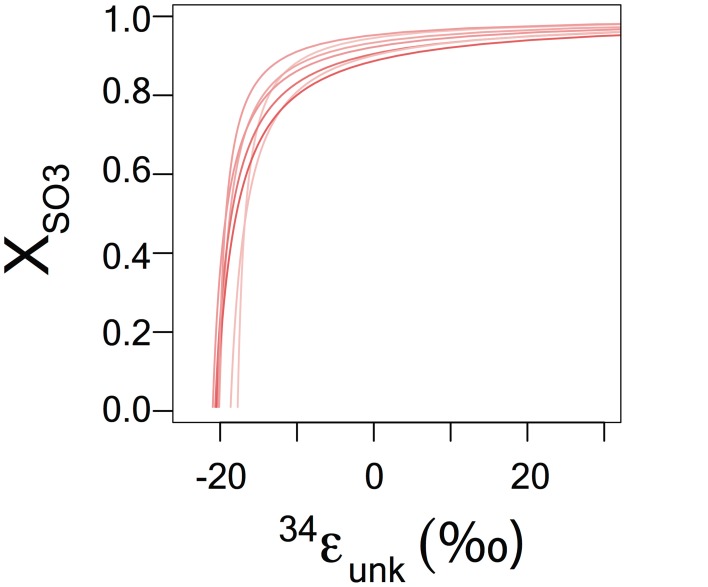
The relationship between the magnitude of a secondary fractionation (34αsecondary) and the proportion of reduced sulfur deriving directly from sulfite reduction (XSO3). The balance (1- XSO3) is from the parallel reduction of bound sulfonate. Errors estimates are from the propagation calculation, incorporating both isotope and concentration analysis analytical errors (see below).